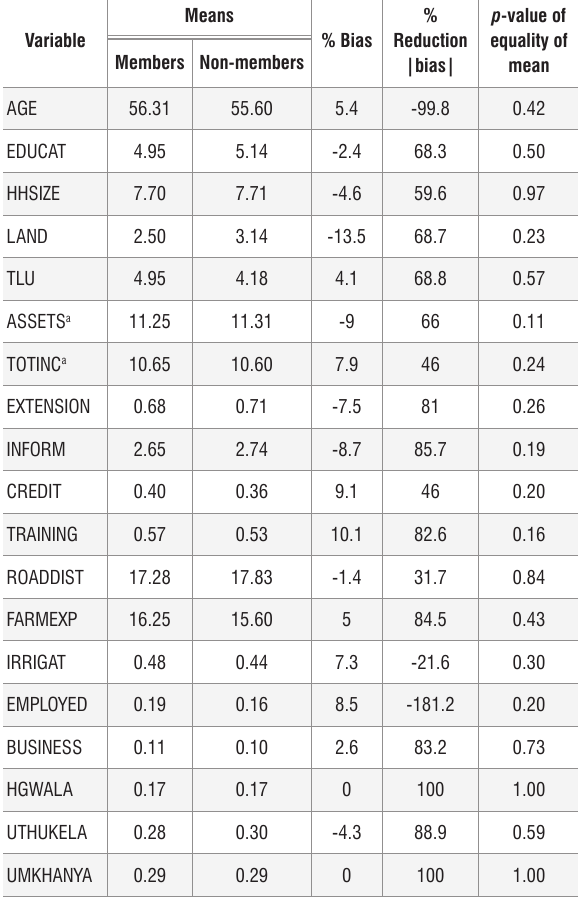
Impact of group membership on the probability of inorganic fertiliser use